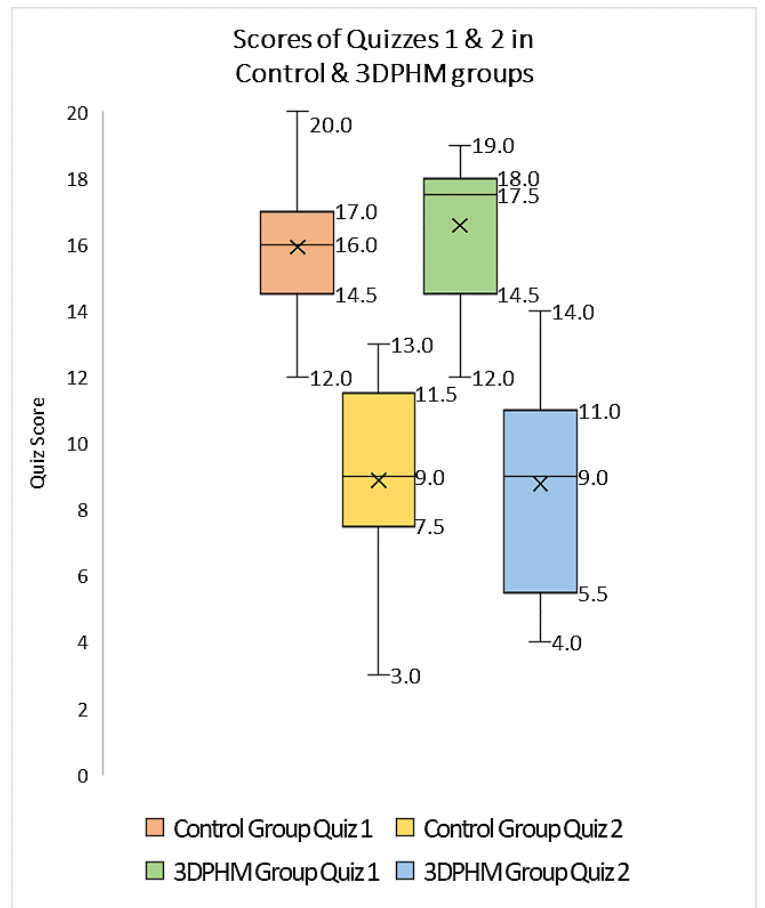
Figure 4. Boxplot of the scores (out of 20) achieved by 3D printing and control groups in Quiz 1 and Quiz 2. 3DPHM-3D printed heart model. Reprinted with permission under open access from Lau and Sun [27].